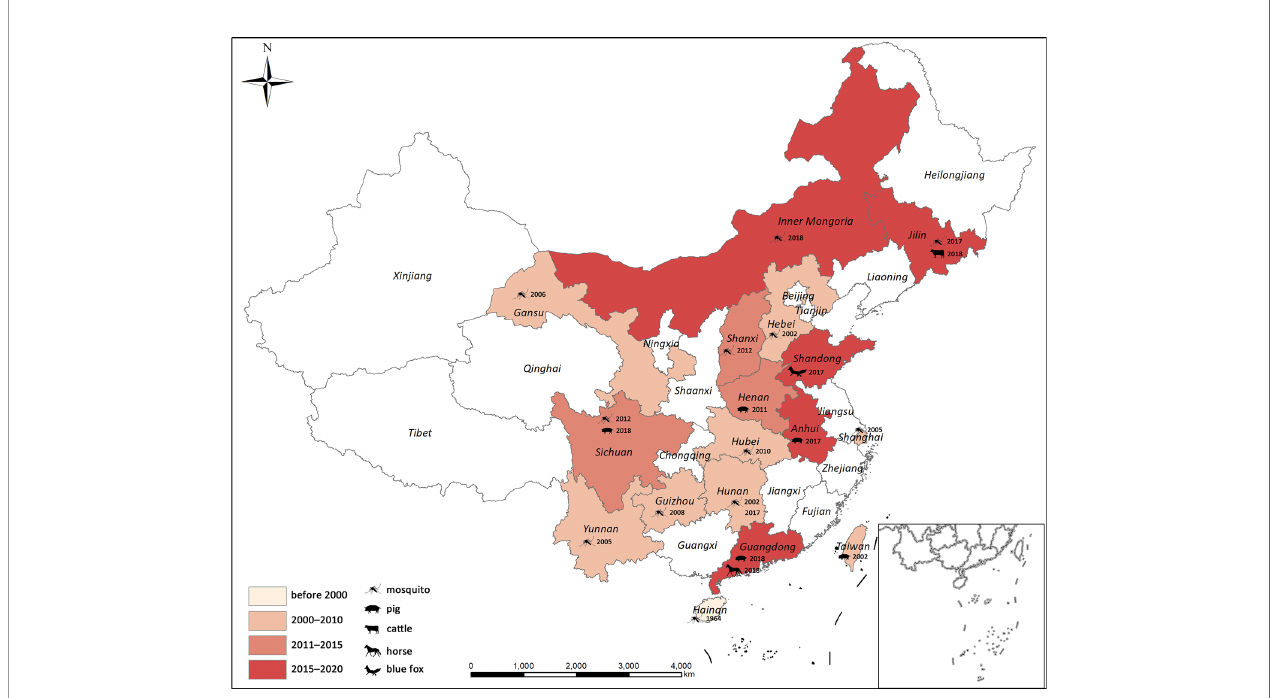
FIGURE 6 | Geographical distribution of GETV in China. Years correspond to the fi rst GETV detection in each